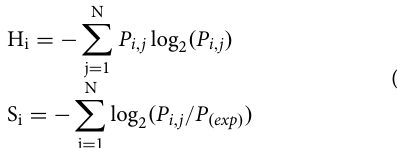
( Table 1 ) and translated employing the Biopython (37) package Bio.SeqIO. The number of protein sequences was reduced to a set of unique sequences, i.e., containing one representative for sequences with identical amino-acid compositions. Each unique sequence was aligned to the protein sequence of the reference NC_045512.2 using the Biopython (37) package Bio.pairwise2 module with a gap-opening penalty of − 10 and a gap-extension penalty of −